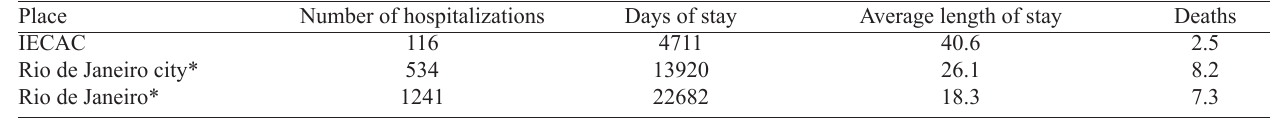
Table 4. Length of hospital stay and hospital mortality by place of occurrence, May 2011 to April 2012. Place